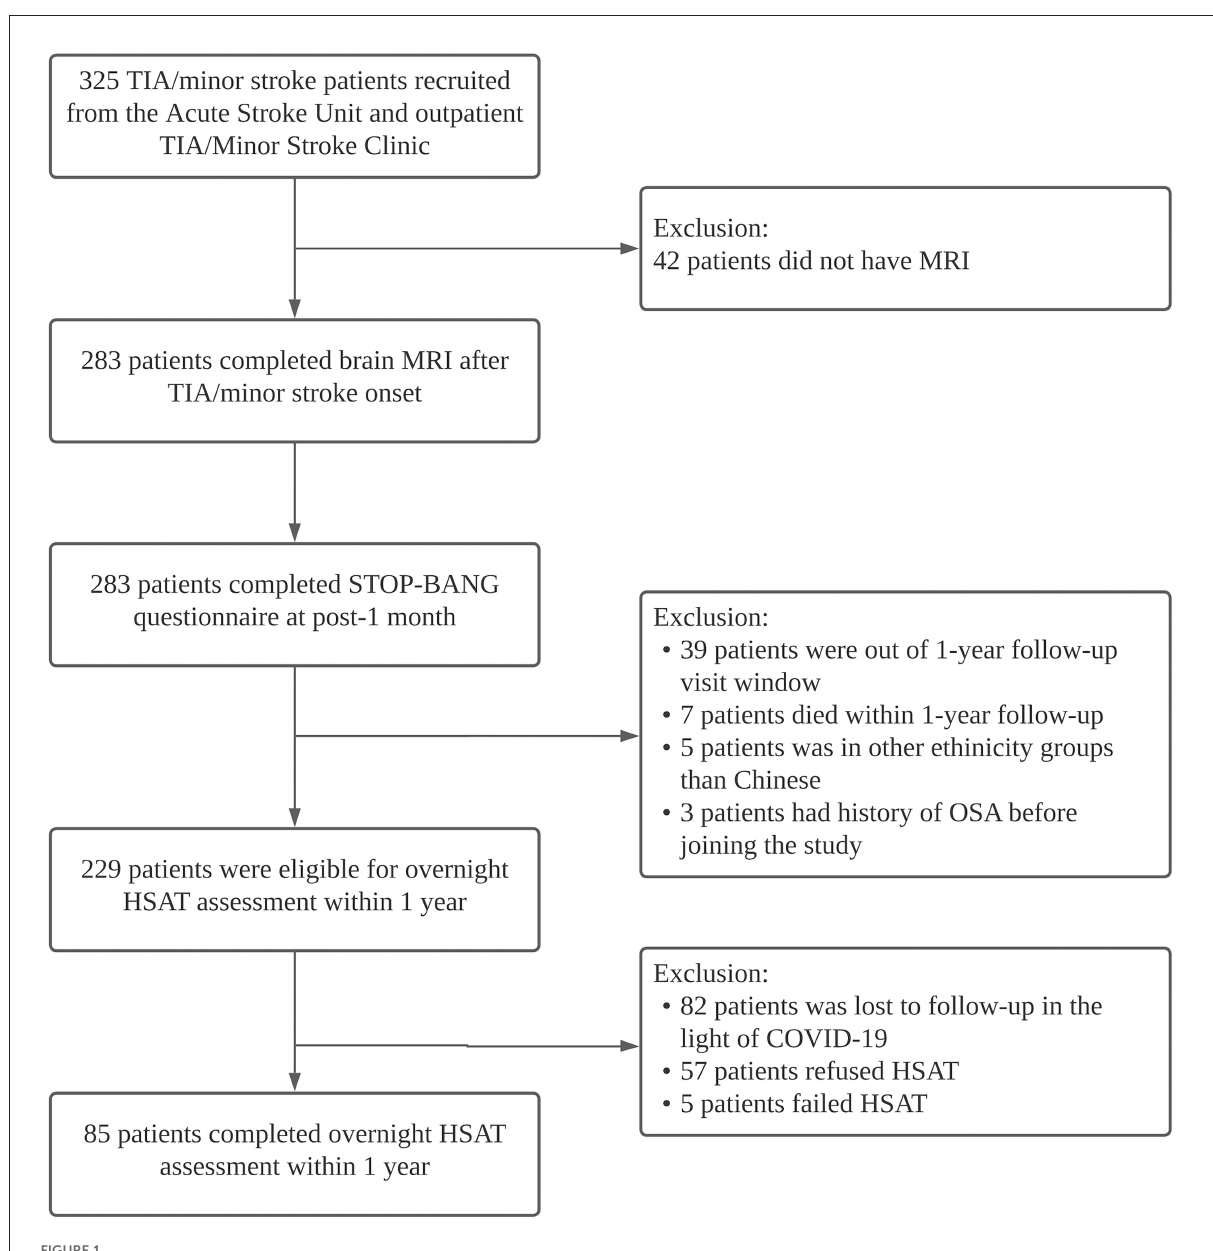
FIGURE1 Study flow diagram. MRI, magnetic resonance imaging; TIA, transient ischemic attack; HSAT, home sleep apnea test.